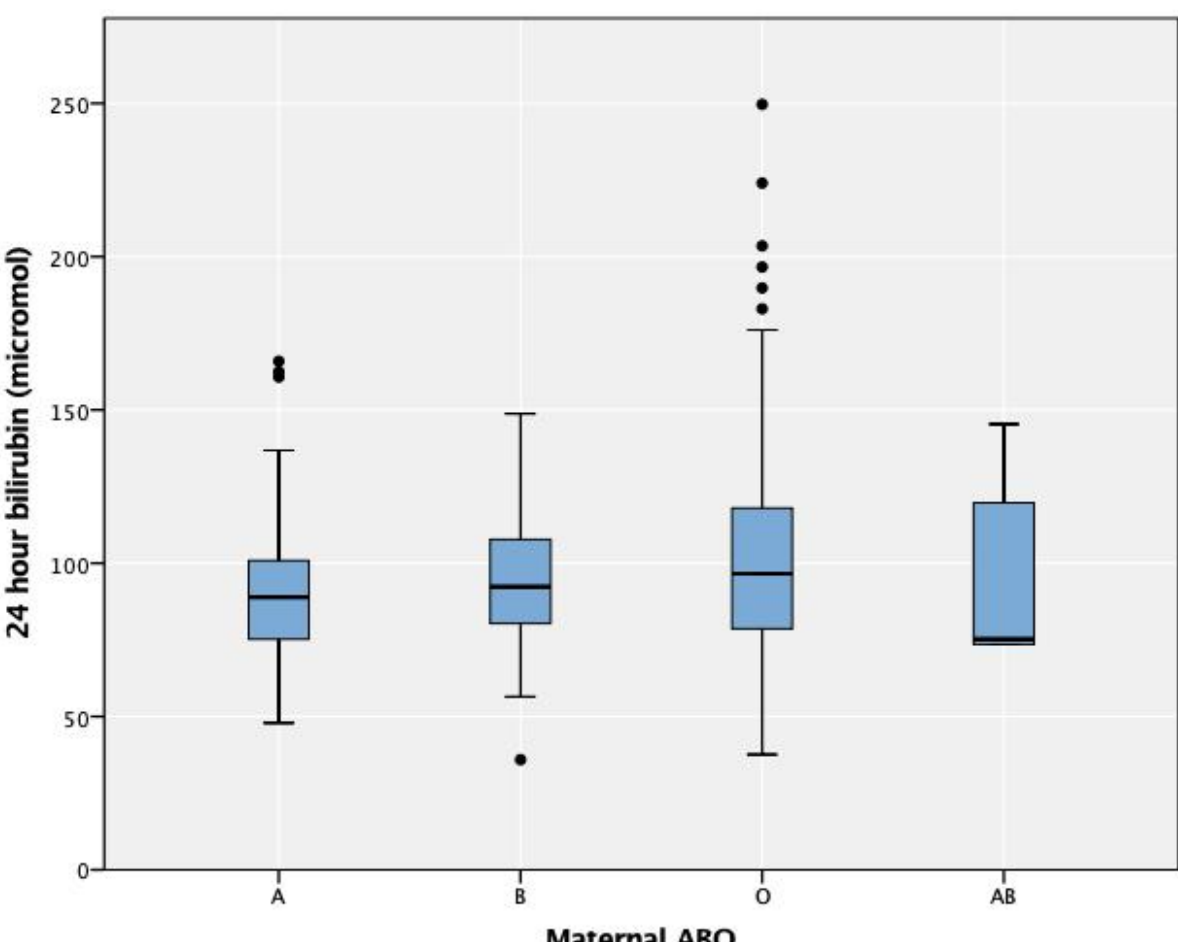
Figure 1. Twenty-four-hour serum bilirubin by maternal ABO blood groups. The circles represent the outliers of the bilirubin levels in each type of blood group.